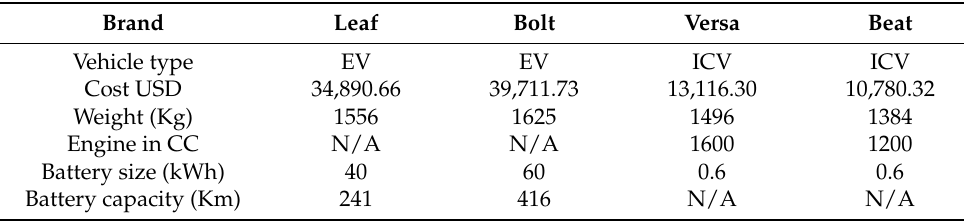
Table 1. General parameters of the chosen